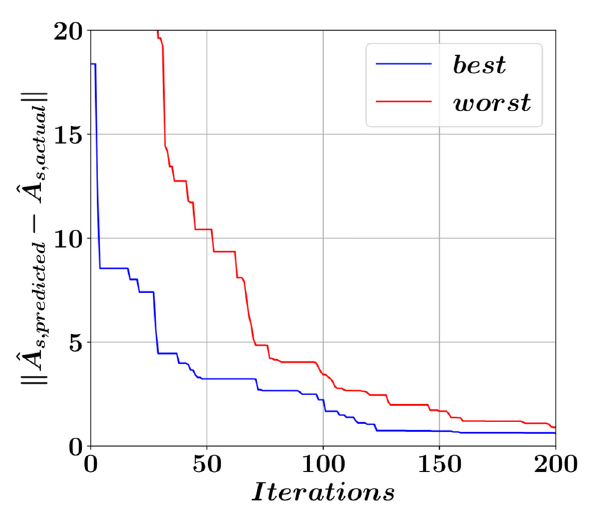
Figure 10. Equation performance throughout the harmony search iterations.